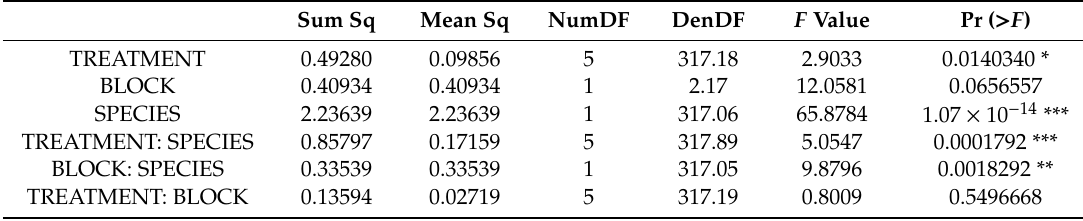
Table A5. Type III Analysis of Variance Table with Satterthwaite’s